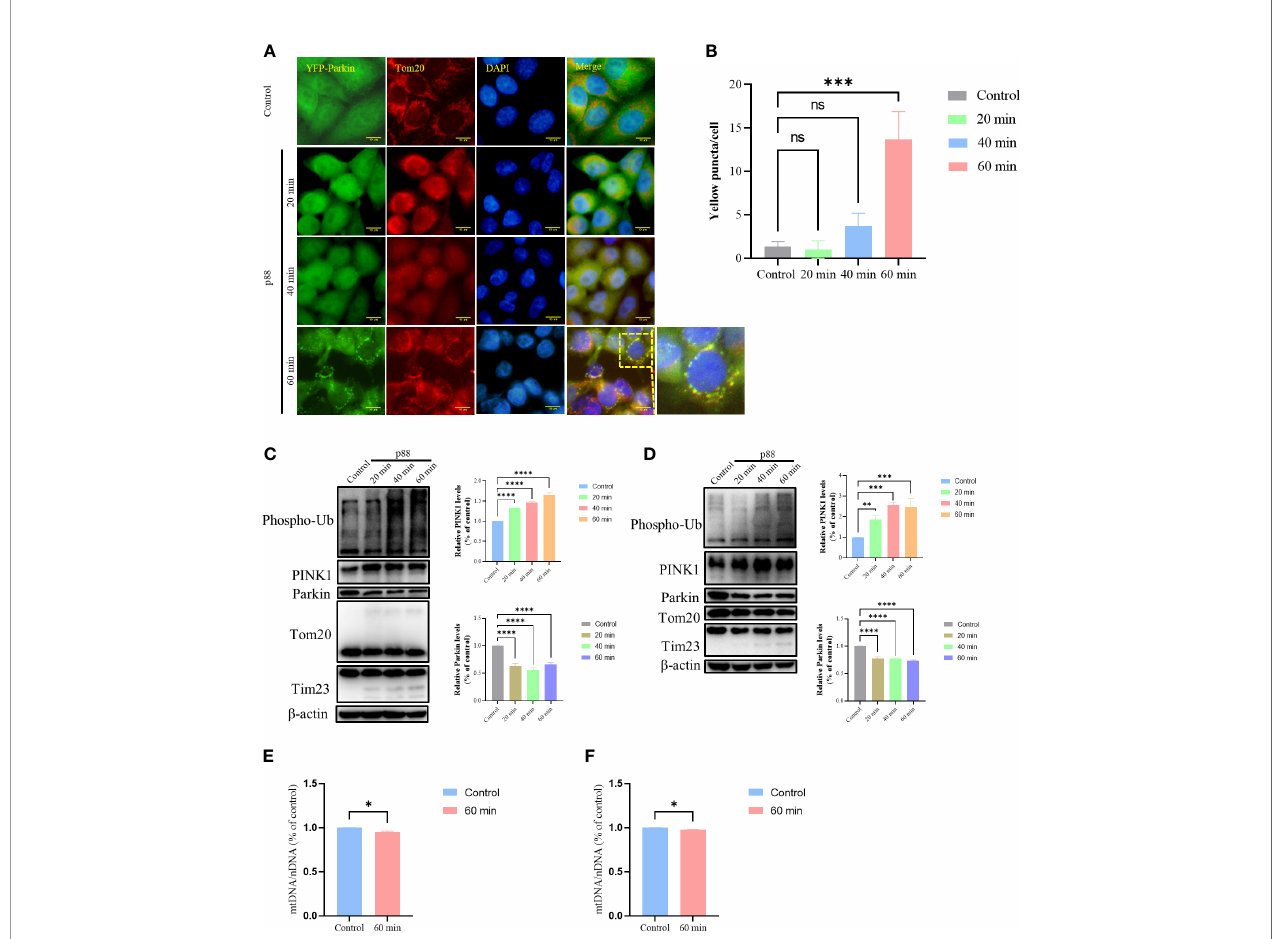
FIGURE 6 | p88 induces mitophagy by PINK1/Parkin pathway in GES-1 cells. Representative fl uorescence photographs (Scale bar, 10 m m) of mitophagy in HeLa YFP-Parkin cells treated with p88 (12 m g/ml) for 1 h (A) . The level of mitophagy was evaluated by the number of yellow puncta (B) . The asterisks indicate signi fi cant differences from the control. n = 3. *** p <0.001. ns, no signi fi cance. The expression levels of mitophagy-related proteins in HeLa YFP-Parkin (C) and GES-1 (D) cells were measured by western blot, and the level of change (PINK1 and Parkin) was quanti fi ed. After being treated with p88 (12 m g/ml) for 1 h, HeLa YFP-Parkin (E) and GES-1 (F) cells were detected with relative mitochondrial DNA content (mtDNA/nDNA) by RT-qPCR. The asterisks indicate signi fi cant differences from the control. n = 3. * p <0.05, ** p <0.01, *** p <0.001, **** p